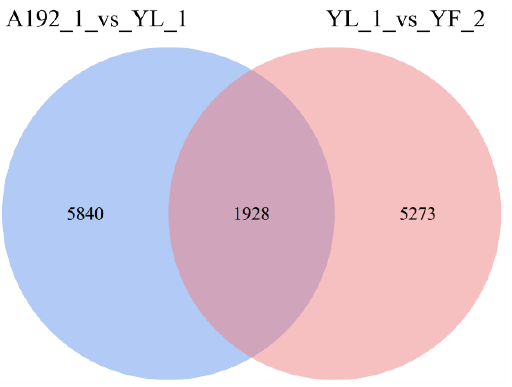
Figure 2. Venn diagram showing the numbers of DEGs in the A192-1 vs. YL-1 and YL-1 vs. YF-2 comparison groups.